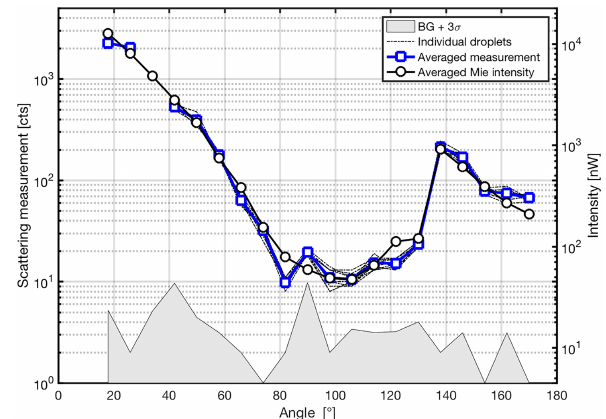
Figure 5. Characterization of the polar nephelometer with dry polystyrene spheres with a nominal monodisperse diameter of 49.7 ± 2.0µm. The image analysis results were used as input for Mie calculations. The averaged Mie scattering function is shown in black.